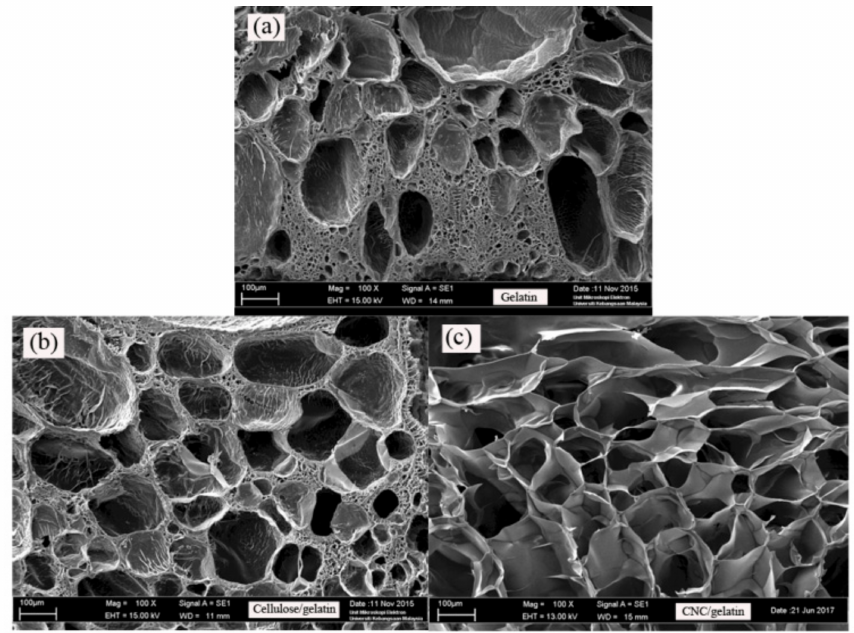
Figure 7. Micrographs of swollen ( a ) gelatin hydrogel; ( b ) hydrogel A; and ( c ) hydrogel B.